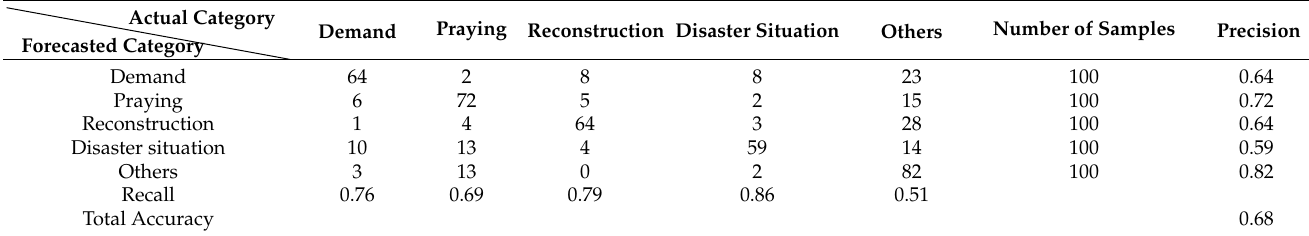
Table A3. Results of the manual test of the BTM.